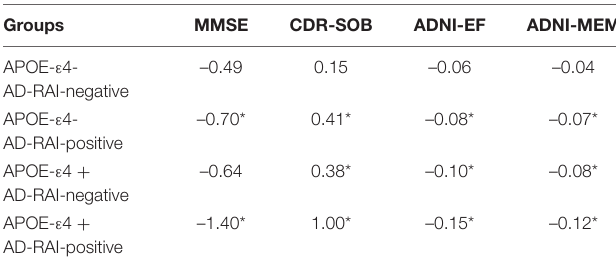
TABLE 4 | Estimates of mean yearly rates of change in the cognitive measures of individuals with different APOE genotypes and AD-RAI levels. Groups